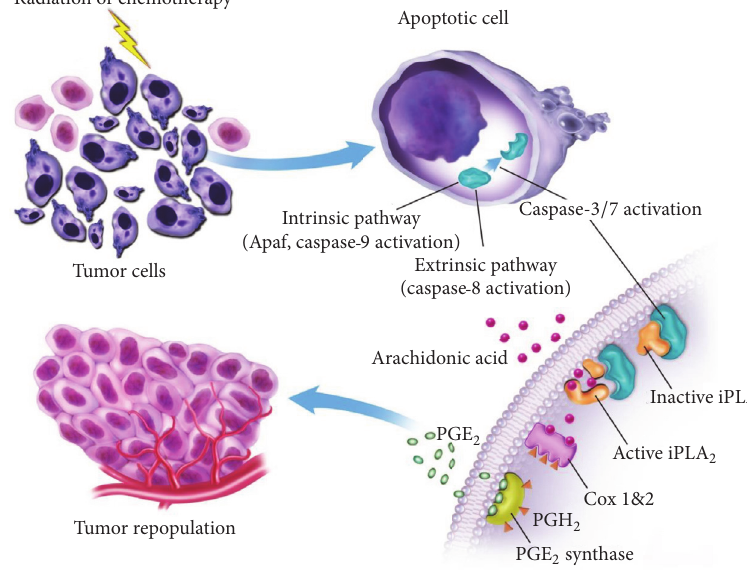
Figure 2: Schematic representation of apoptosis-mediated tumour cell repopulation. In tumours damaged by cytotoxic therapies apoptotic cells activate caspase-3 and caspase-7 through either intrinsic pathways, involving Apaf and caspase-9 activation, or extrinsic pathways, involving caspase-8 activation. Activated caspase-3 and caspase-7 activate calcium-independent phospholipase A2 (iPLA 2 ), which increases the synthesis and release of arachidonic acid. Arachidonic acid is then converted into PGH 2 by COX-1 and COX-2, which is subsequently converted into PGE 2 by the enzyme PGE 2 synthase. PGE 2 stimulated cancer stem cell proliferation and tumour repopulation (figure was adapted from [39] with the permission of Professor